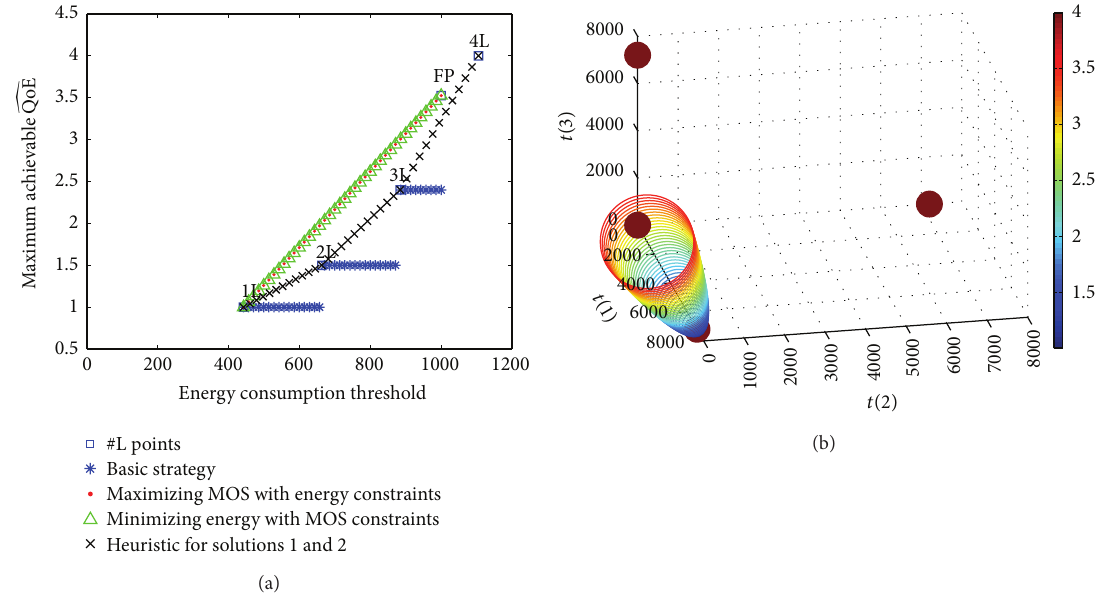
Figure 9: Situation 3 in the objective and input space including original